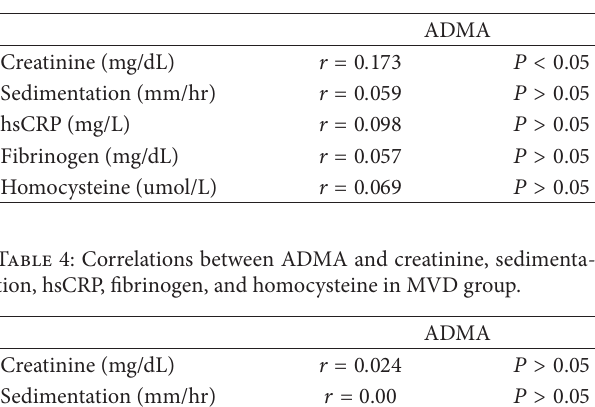
Table 3: Correlations between ADMA and creatinine, sedimenta- tion, hsCRP, fibrinogen, and homocysteine in all groups.